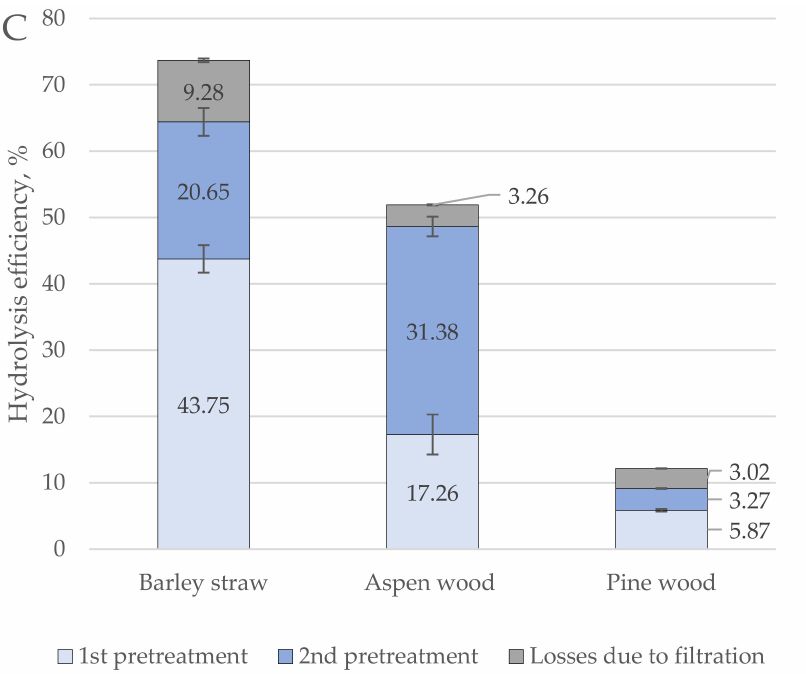
Figure 3. Glucose ( A ) and xylose ( B ) yields and hydrolysis efficiency ( C ) of barley straw, aspen wood, and pine wood after the first and second pretreatment. The figure also shows the losses due to filtration after pretreatment. Each value on the graph represents the mean of one colored part of the beam. The corresponding standard deviation is shown as small bars on top of the colored